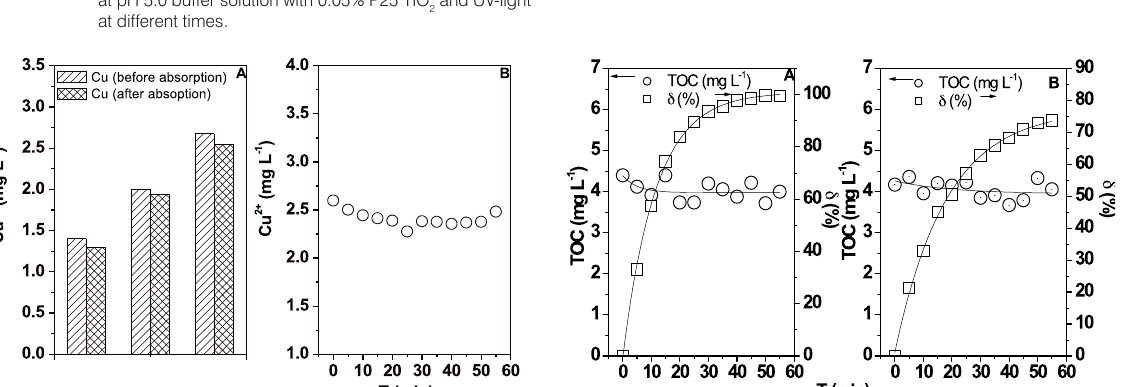
Figure 4. The adsorption of ACBK on the surface of P25 TIO the change of Zeta potential of P25 TIO concentration of Cu 2+ . and UV-light 2